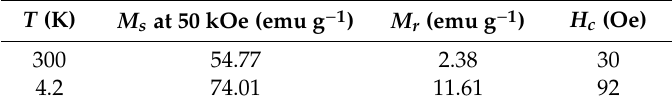
Figure 6. Hysteresis curves of Sr 3 Co 2 Fe 24 O 41 powder material at 4.2 K ( a ) and 300 K ( b ). Table 1. Magnetic properties of Sr 3 Co 2 Fe 24 O 41 powder material.